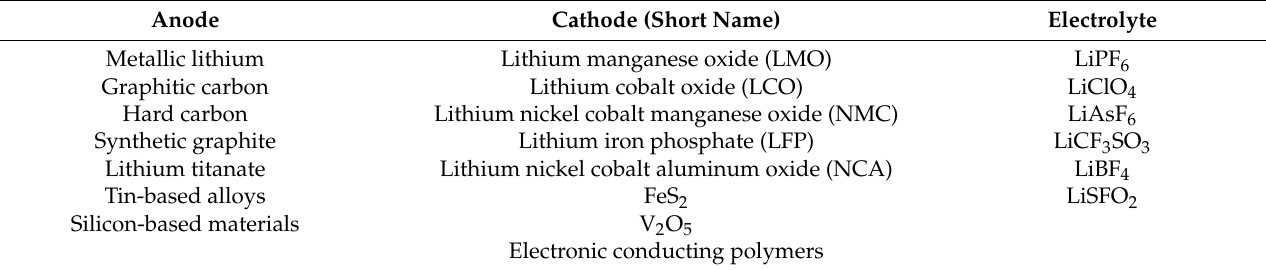
Table 3. The general material composition of the individual components of LIBs